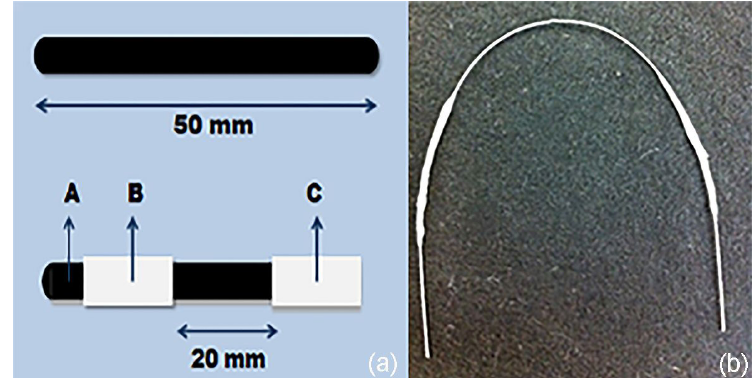
Figure 1. Raw material (a) and commercial archwire (b) with respective work length. A: electrical contact region, B and C: insulated region. The region between B and C represents the electrode area exposed to the